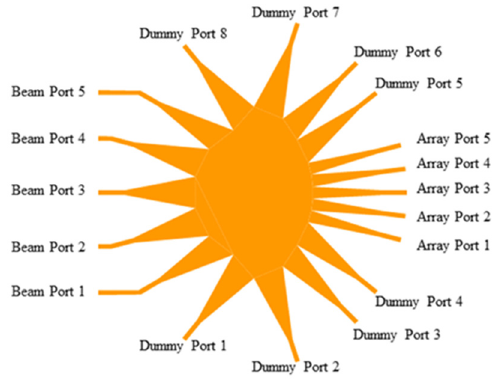
Figure 5. The designed Rotman lens.